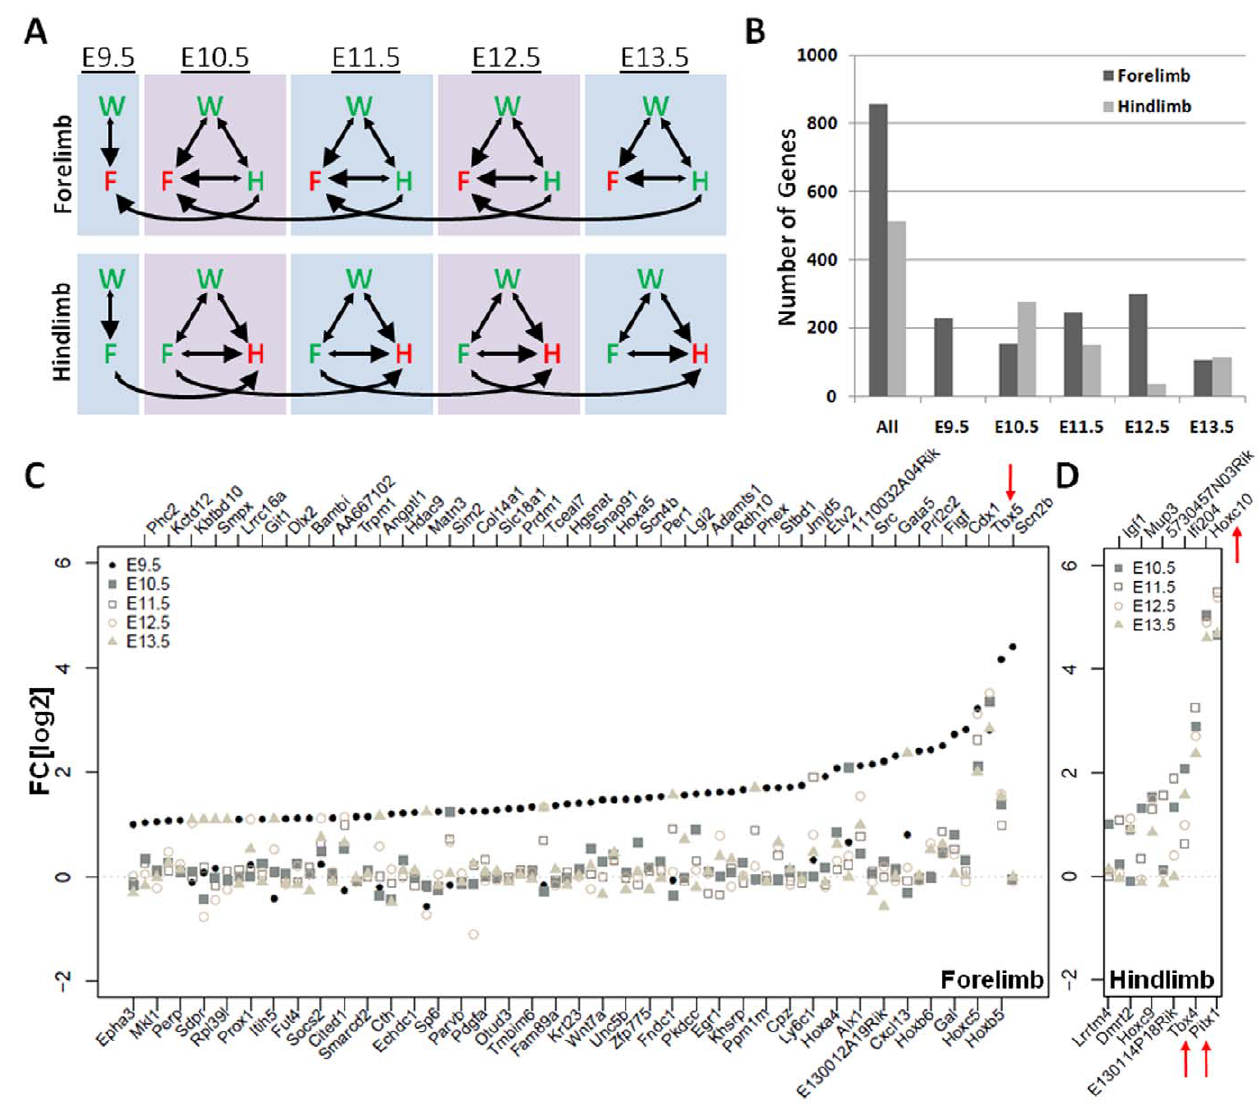
Figure 7. Identifying Genes that Contribute to Limb Identity. To identify genes specifically enriched in the forelimb or hindlimb, we adjusted for the developmental delay of hindlimbs by comparing forelimbs to same stage hindlimbs as well as to hindlimbs from a subsequent time point (A). More forelimb enriched genes were identified (B), and the genes with . 2 fold up-regulation in the forelimb (C) or hindlimb (D) are displayed. Genes previously known to function as a limb-identity determinant are marked by red arrows ( Tbx5 ; Hoxc10 , Tbx4 , Pitx1